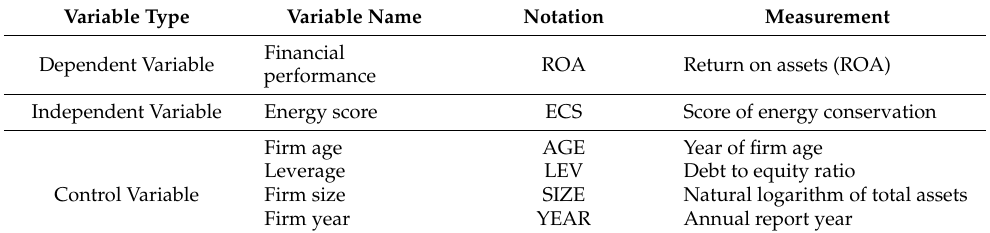
Table 2. Variable